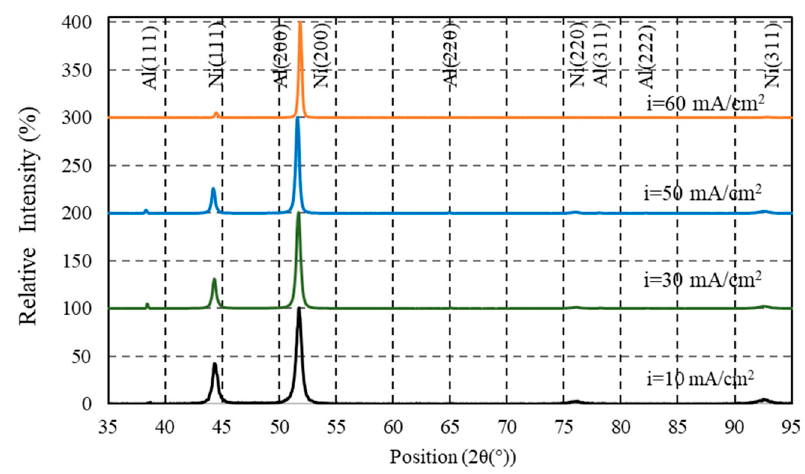
Figure 7. The XRD pattern of Ni-Mo/Al composite coatings obtained at different current densities.